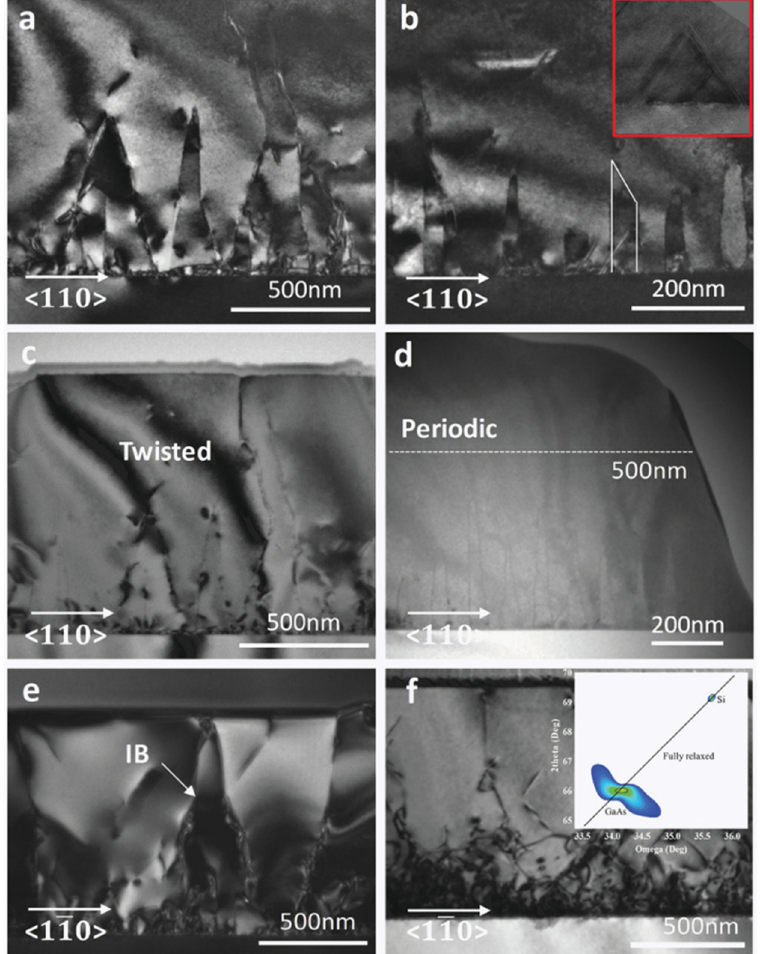
Figure 9. Cross-sectional TEM measurements of inversion boundary (IB) propagation and annihilation of sample without and with Si bu ff er. Dark field TEM images with [110] direction view for sample ( a ) without and ( b ) with Si bu ff er; inset: a staking fault at nucleation layer. Bright field TEM images with [110] direction view for sample ( c ) without and ( d ) with Si bu ff er. TEM images with [11(cid:3364)0] direction view for sample ( e ) without and ( f ) with Si bu ff er; inset: XRD reciprocal space mapping (RSM) image of fully IB-free 1 µ m GaAs on on-axis (001) Si substrate. Reprinted from Reference [128] © 2020, the authors, under CC BY.